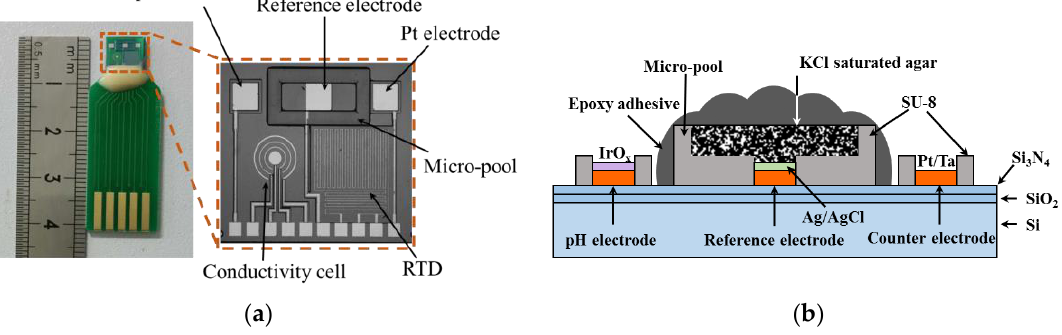
Figure 1. ( a ) Photograph of the multi-parameter sensor chip; and ( b ) a cross-sectional view of the pH sensor; the third (right) electrode acts as the counter-electrode for the electrodeposition of IrOx.